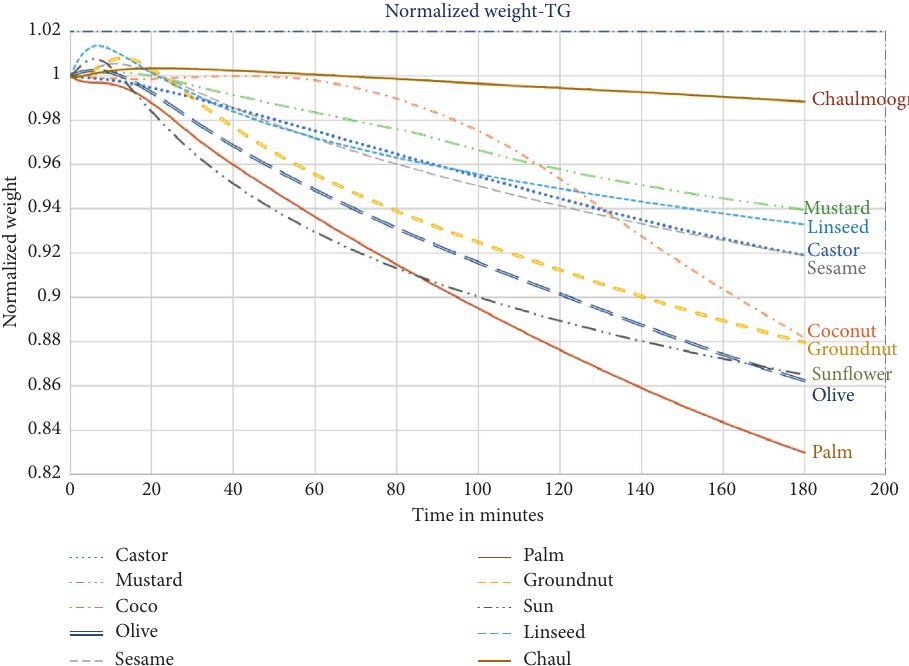
Figure 22: Isothermal TGA of different oils in oxygen.